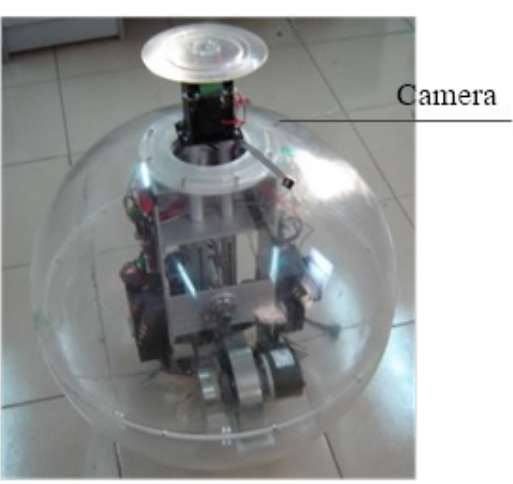
Fig. 2 Standing mode of the